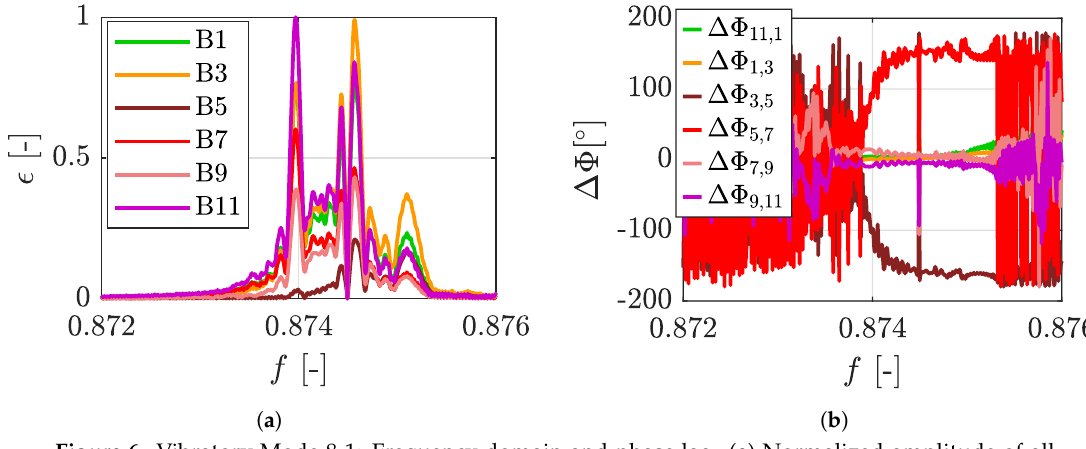
Figure 6. Vibratory Mode 8-1: Frequency domain and phase lag. ( a ) Normalized amplitude of all SG-applied blades during resonance M8-1; ( b ) Phase lag of all SG-applied blades during resonance M8-1 in the frequency